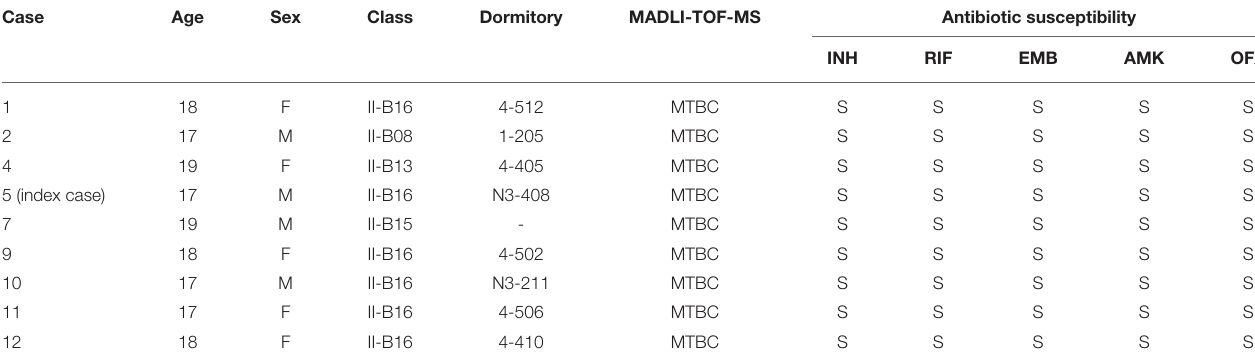
TABLE 3 | Characteristics of outbreak